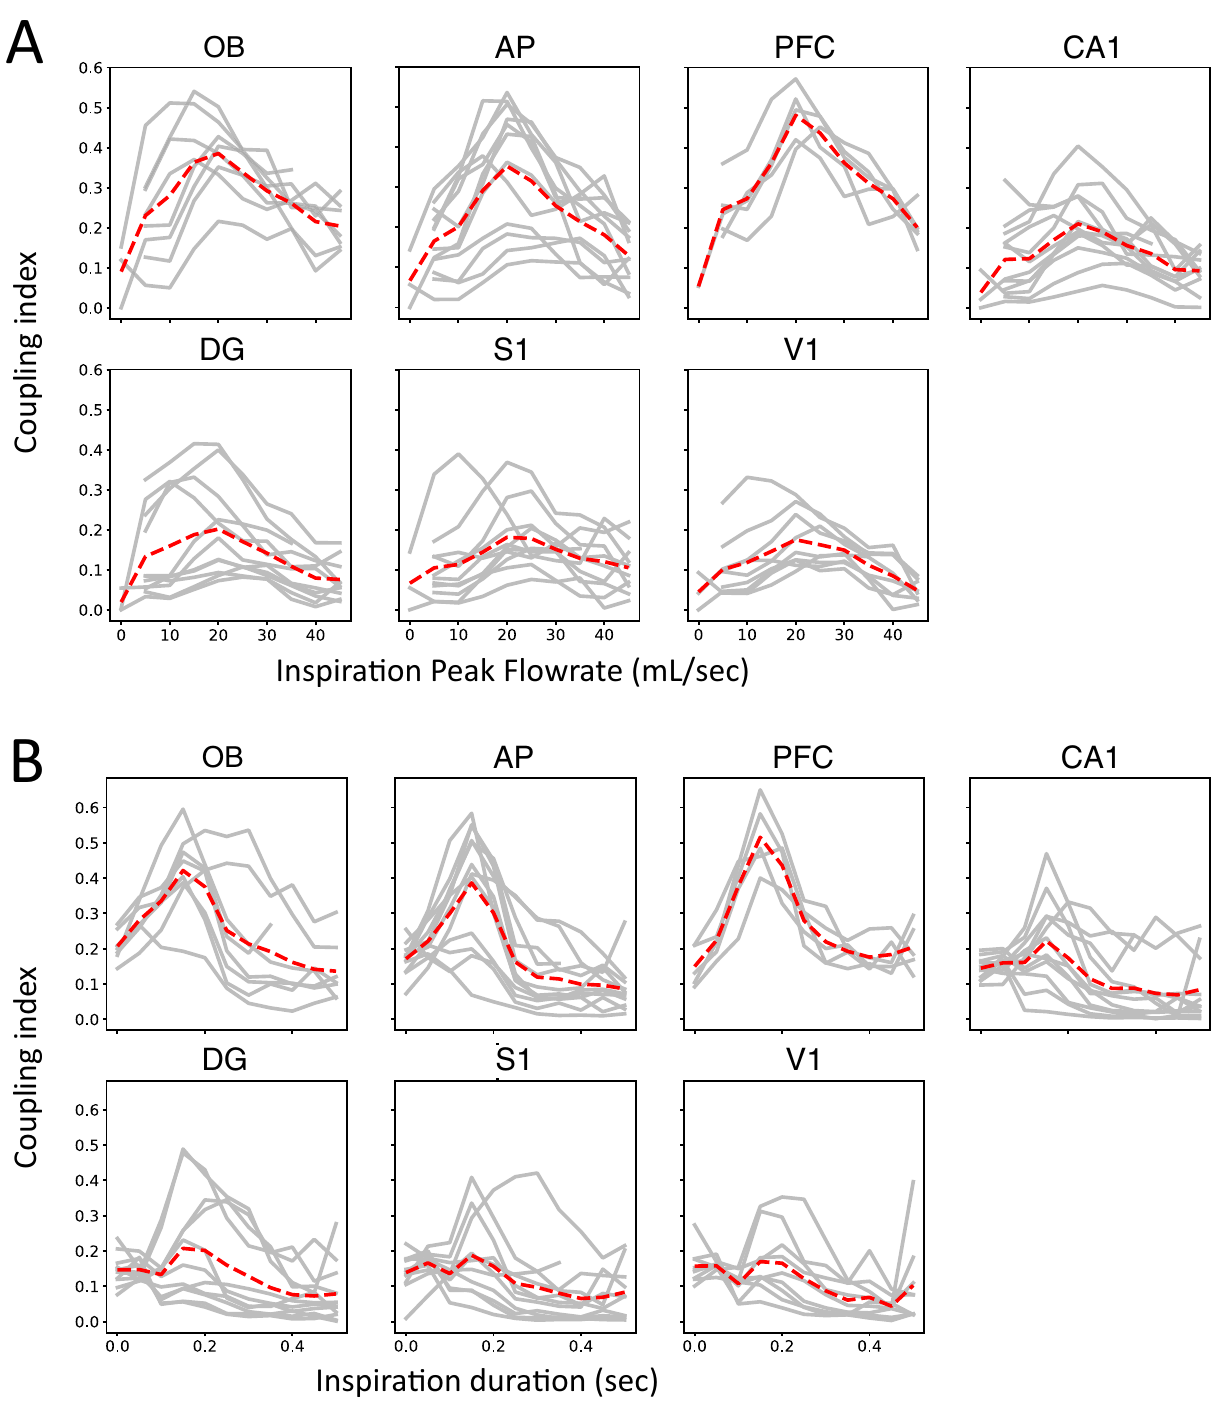
Figure 7. Coupling index as a function of inspiration peak flow rate iPF ( A ) and inspiration duration iDur ( B ). Data are presented individually for each animal (solid lines, see Table 1 for sample size), and averaged across animals (dotted red lines). The inverted U-shape of coupling index as a function of iPF and iDur was assessed by comparing two generalized mixed linear-models either with or without the quadratic term (see “Methods” for details). The comparison showed that the iPF quadratic term was significant for all areas (Wald test, p < 0.02, see text for details) and that the iDur quadratic term was significant for some areas (Wald test, PFC: p = 0.01, and trends for AP and OB, p < 0.1, see text for